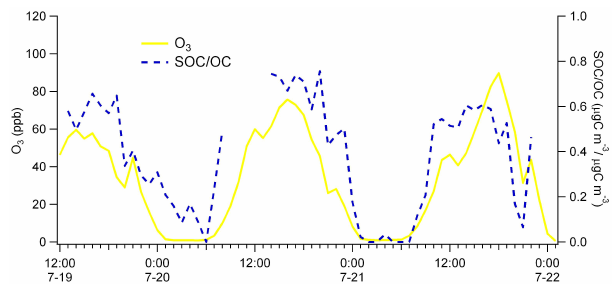
Fig. 9. The variation of SOC/OC ratio and O 3 during the photo- chemical active periods of 19 to 21, July